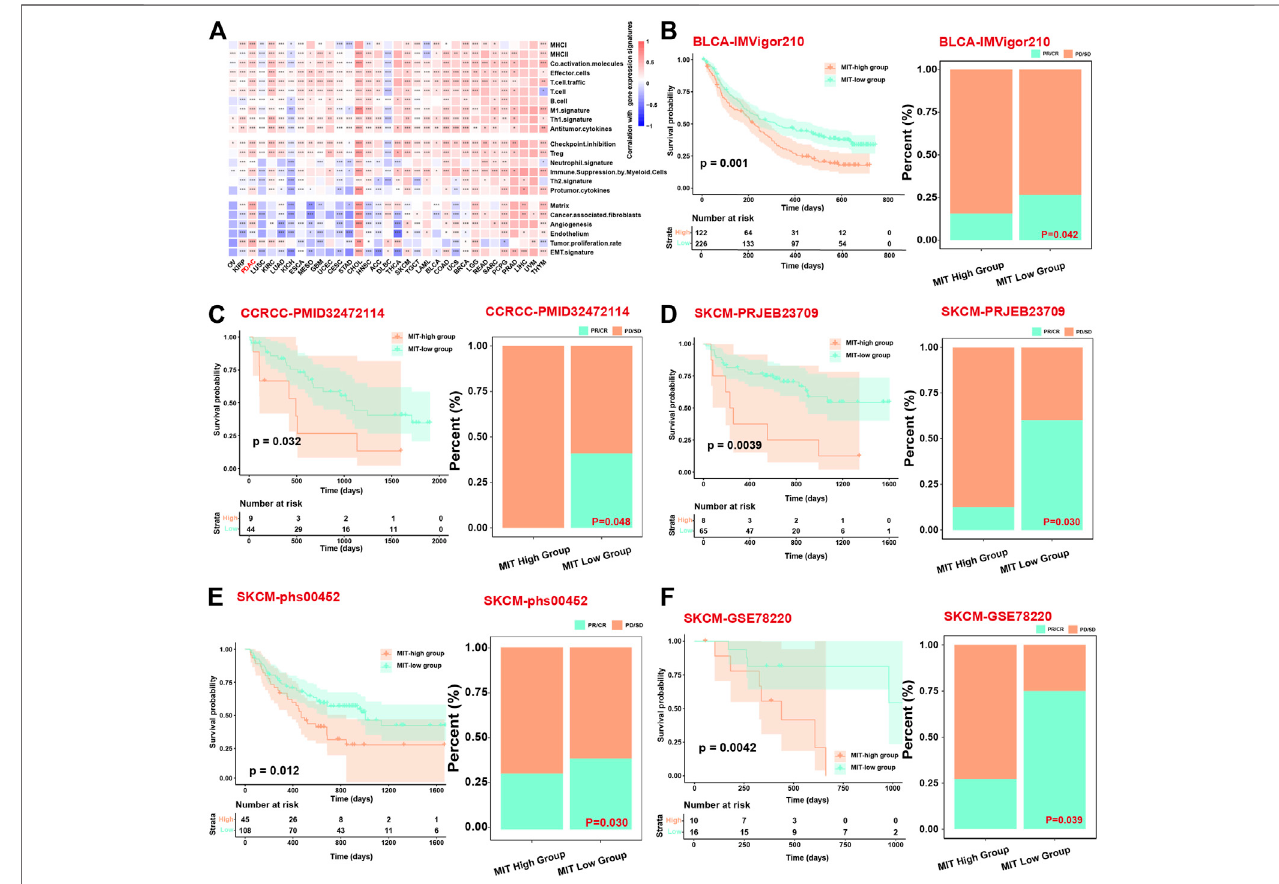
FIGURE 6 | MIT score can be a prognostic factor related to the long-term ef fi cacy of immunotherapy. (A) , Heatmap shows the correlation between the MIT score and functional gene expression signatures in 33 cancer types from TCGA. (B – F) , Kaplan Meier curves showing the survival difference between MIT-high and MIT-low group (left panel) and bar chart showing the difference in proportion of responders and non-responders between MIT-high and MIT-low group (right panel) in BLCA, CCRCC, SKCM patients, respectively. The p -values for survival difference are calculated via a two-sided log-rank test, and the p -values for proportion difference are calculated from fi sher ’ s exact